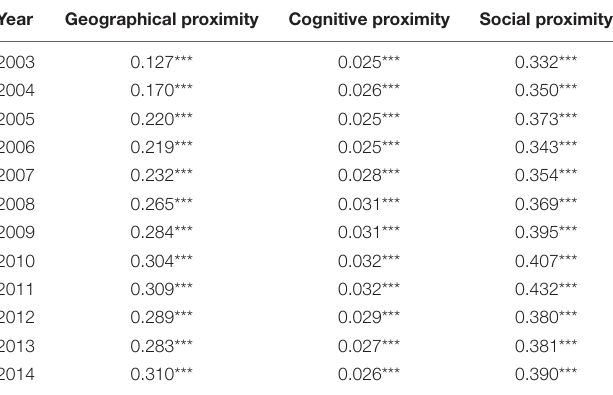
TABLE 2 | Moran’s I -value for lnpat under different weight